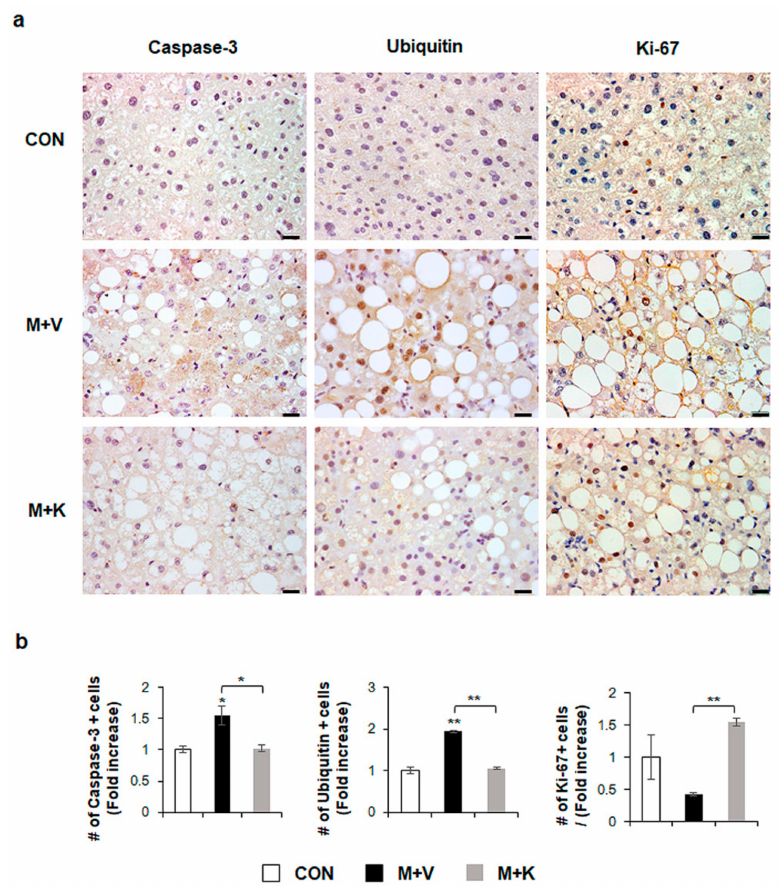
Figure 3. KT suppresses apoptosis and promotes proliferation of hepatocytes in MCD-fed db / db mice ( a ) Immunohistochemistry for Caspase-3, Ubiquitin, and Ki-67 for liver sections from representative mice from each group (Scale bars: 20 µ m). ( b ) Quantitative Caspase-3, Ubiquitin, and Ki-67 immunohistochemistry data from all mice. The numbers of Caspase-3, Ubiquitin, or Ki-67- positive cells were counted per field and divided by the number of hepatocytes per field. Results were described as fold increase. Means ± SEM of results are graphed ( n ≥ 3 / group, * p < 0.05, ** p < 0.005 vs. control